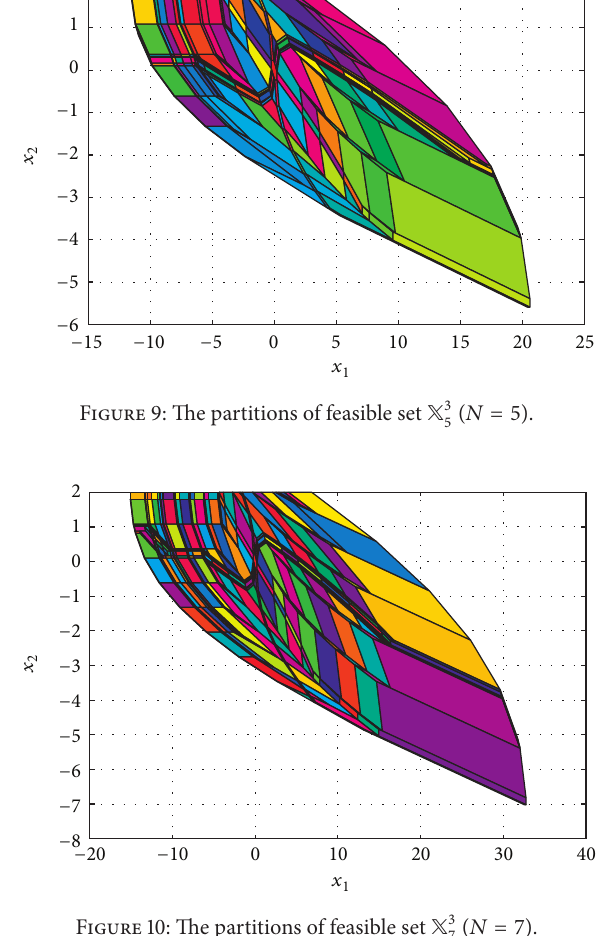
Table 3: Representative partitions of 𝑋 3 1